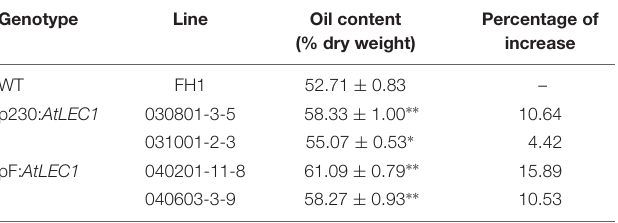
Frontiers in Plant Science |